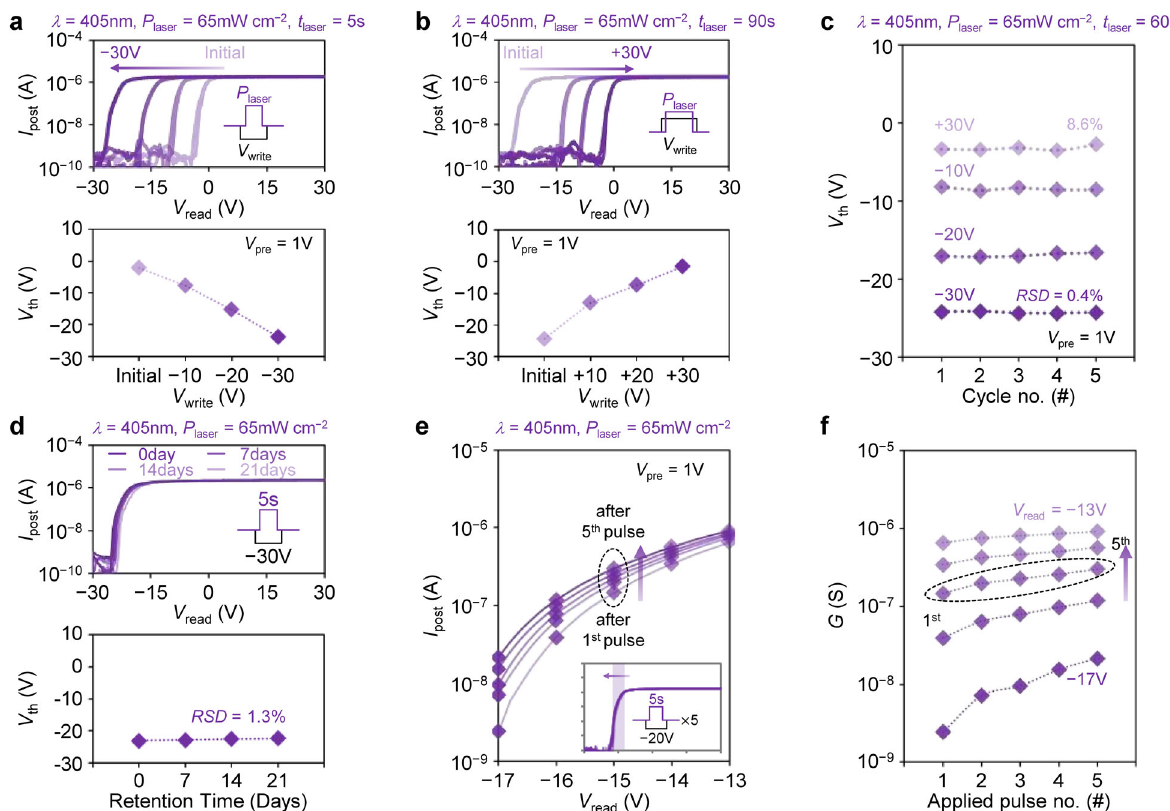
Fig. 2 Multistate memory characteristics of vdW photoelectroactive synapse. a Negative threshold voltage ( V th ) shift characteristics controlled by optical spikes under negative voltage bias. b Positive V th shift characteristics controlled by optical spikes under positive voltage bias. c Cycle-to-cycle variations in V th with the optical spikes under various V write values. d Retention characteristics of the modulated V th . e Negative V th shift in response to fi ve consecutive co-stimuli spikes. f Interpretation of ( e ) in terms of the synaptic weight modulation with respect to the number of co-stimuli. All V th values were extracted from positive gate sweep